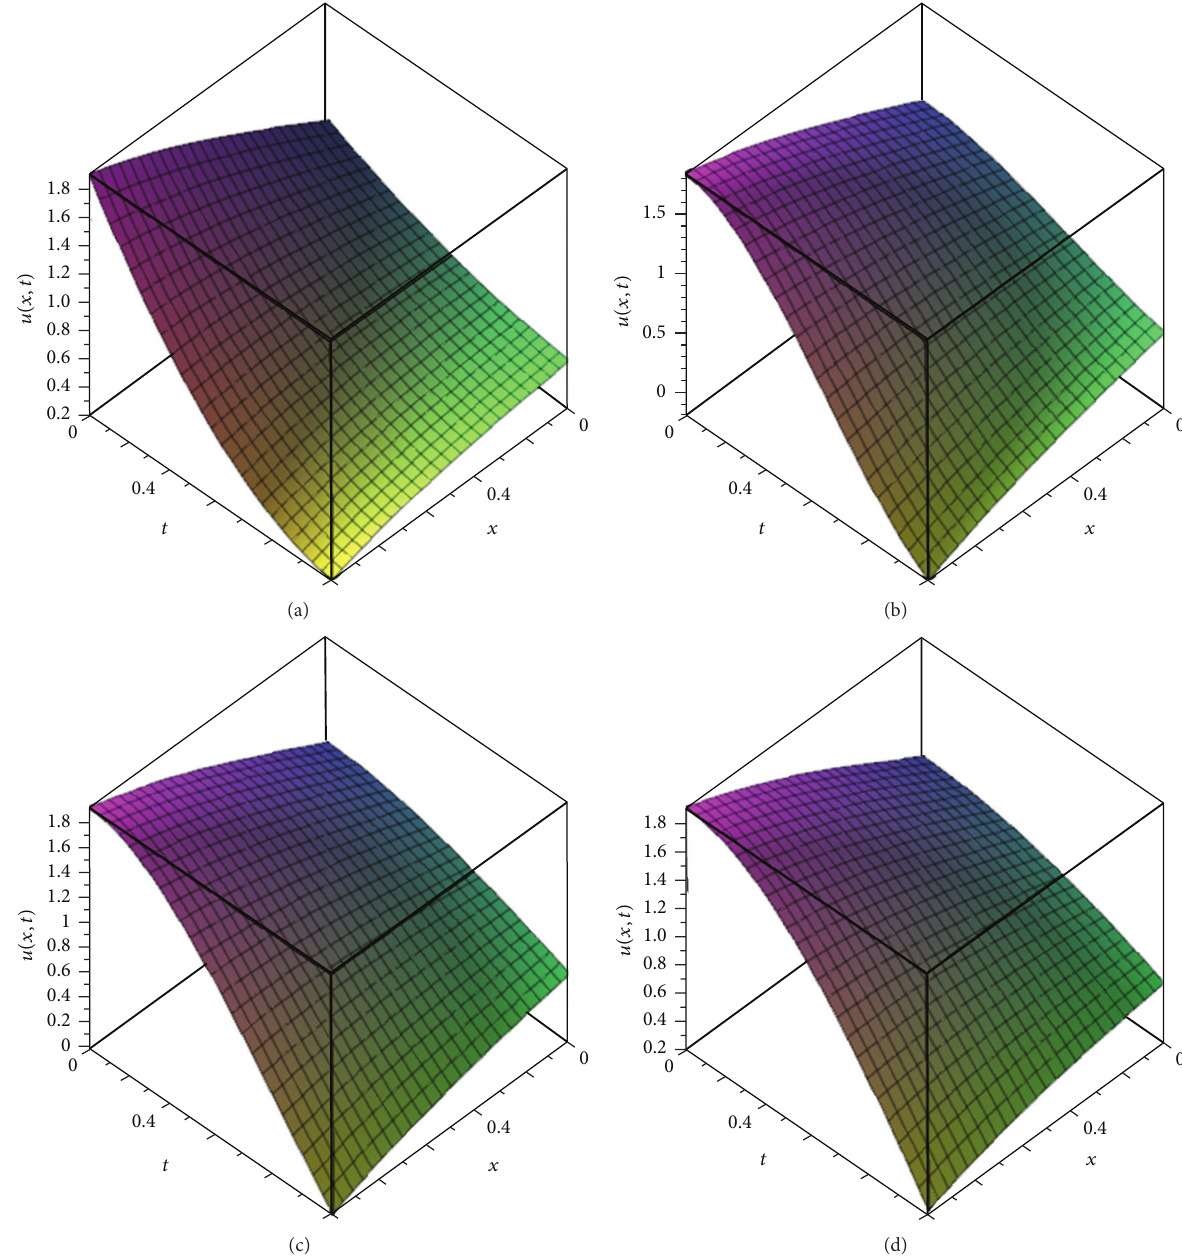
Figure 3: (a) Plot of 𝑢(𝑥,𝑡) with respect to 𝑥 and 𝑡 at 𝛼 = 1 . (b) Plot of 𝑢(𝑥,𝑡) with respect to 𝑥 and 𝑡 at 𝛼 = 1.5 . (c) Plot of 𝑢(𝑥,𝑡) with respect to 𝑥 and 𝑡 at 𝛼 = 1.75 . (d) Plot of 𝑢(𝑥,𝑡) with respect to 𝑥 and 𝑡 at 𝛼 = 2 .